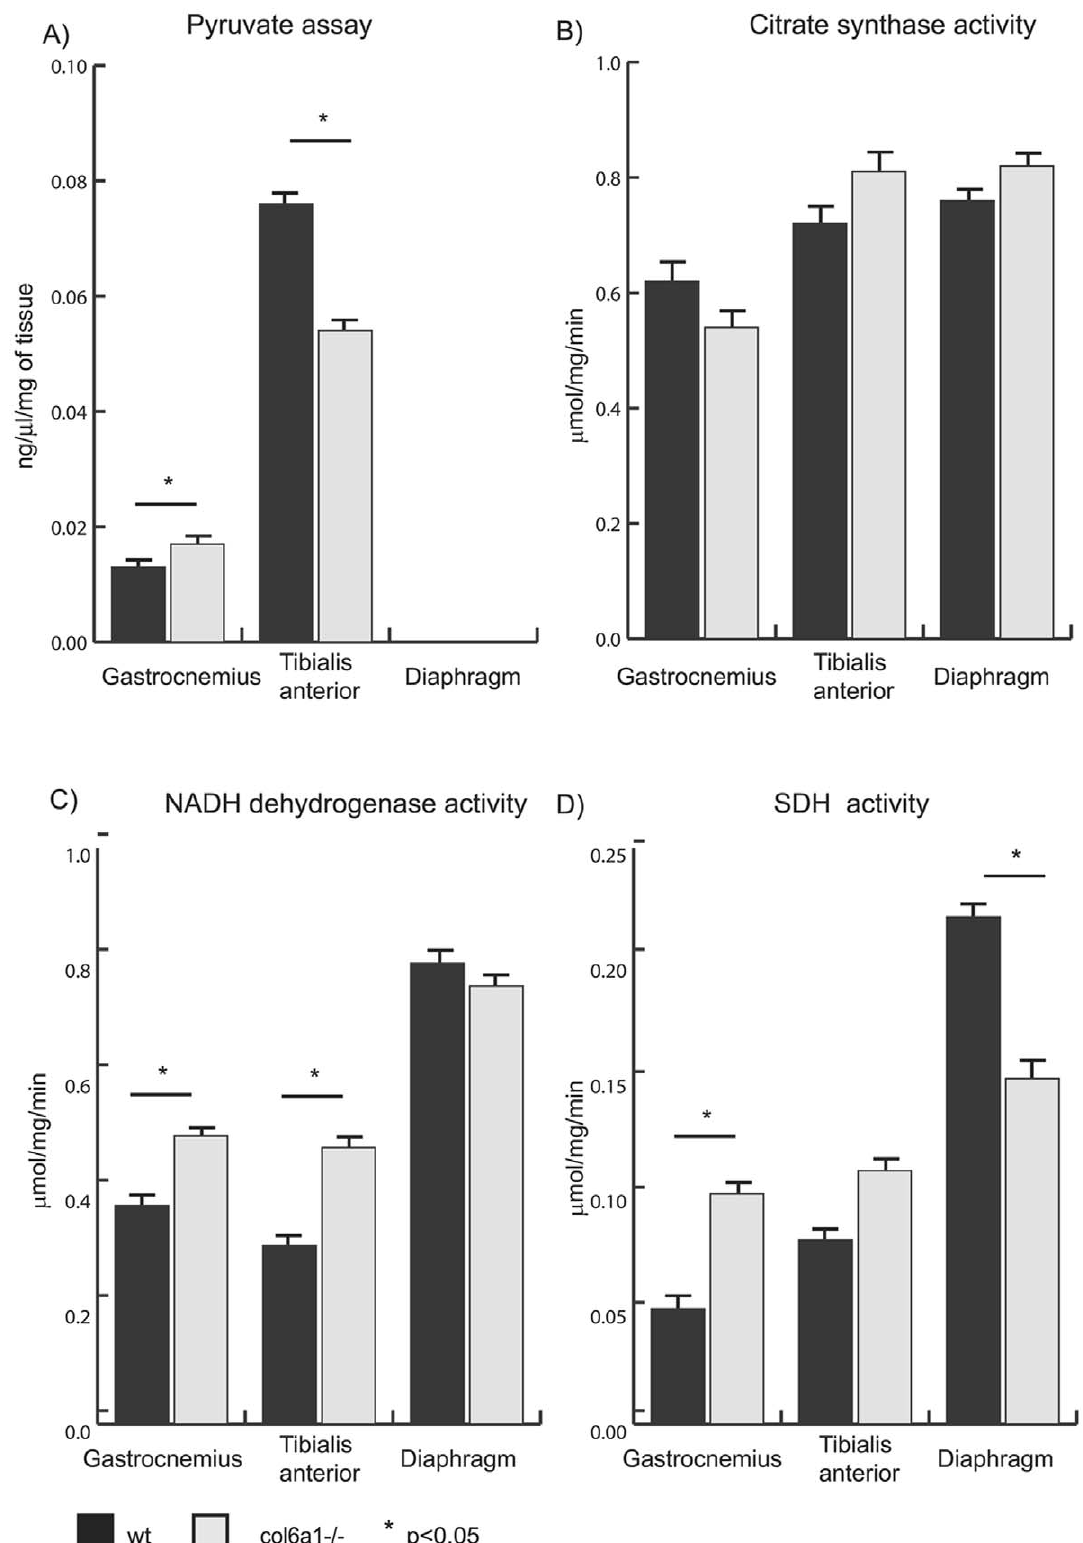
Figure 4. Results of enzymatic assays. Histograms showing pyruvate quantitation (panel A), citrate synthase enzymatic activity (panel B), NADH dehydrogenase (complex I) enzymatic activity (panel C) and succinate dehydrogenase (SDH, complex II) enzymatic activity (panel D) in gastrocnemius, tibialis anterior and diaphragm muscles from Col6a1 2 / 2 and wild-type (wt) mice.